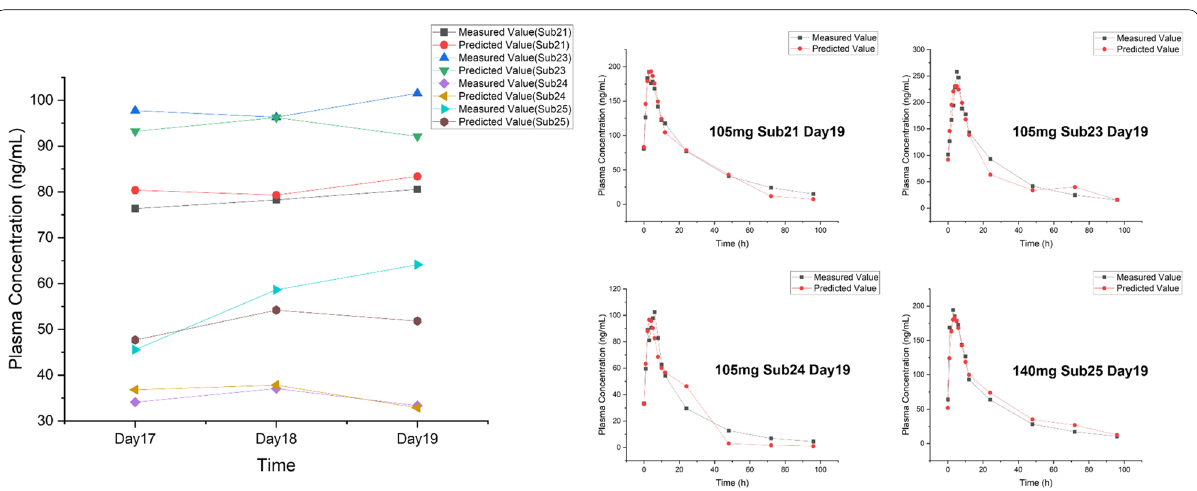
Fig. 7 The predicted and measured time-concentration profiles after multiple dosing of MET306 in 105 and 140 mg